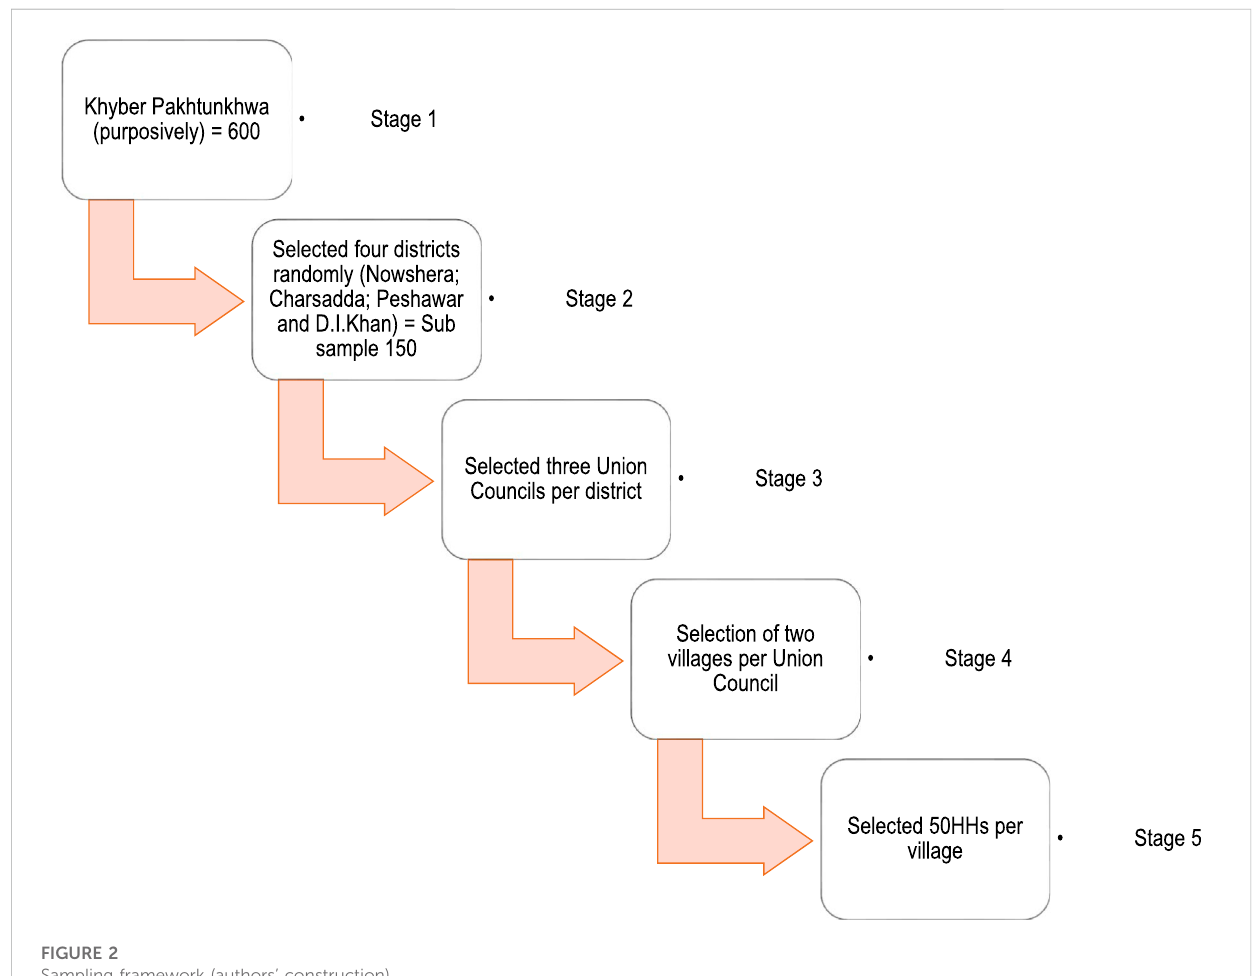
FIGURE 2 Sampling framework (authors ’